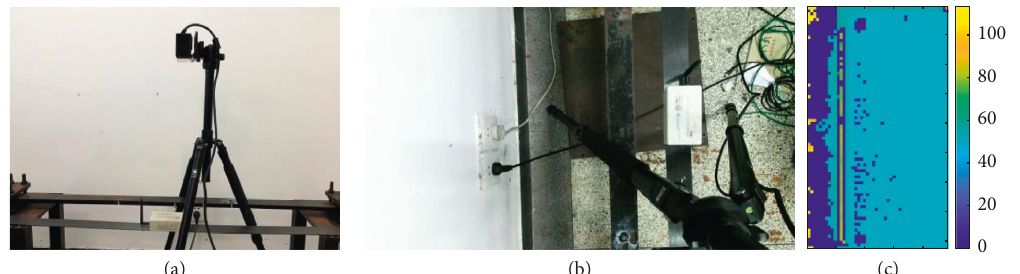
Figure 11: Simply supported carbon plate experimental setup for case 1. (a) Vibrometer placed at the midpoint of the carbon plate, Kinect pointing in a direction parallel to the direction of vibration. (b) Field of view (FOV) of Kinect in the RGB image. (c) ROI raw depth information